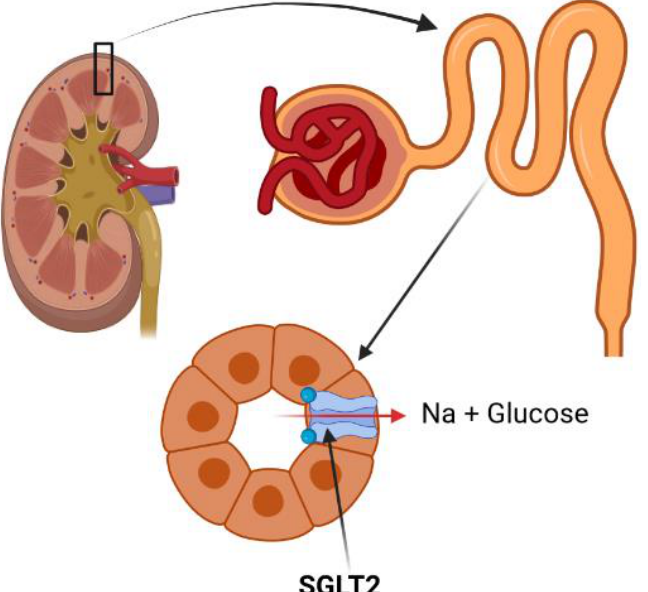
Figure 1. SGLT2 is responsible for glucose and sodium reabsorption in the renal proximal tubules. SGLT2 inhibitors inhibit this process and induce urinary glucose (and sodium) excretion. Table 1. The main characteristics of the SGLT2 protein and its